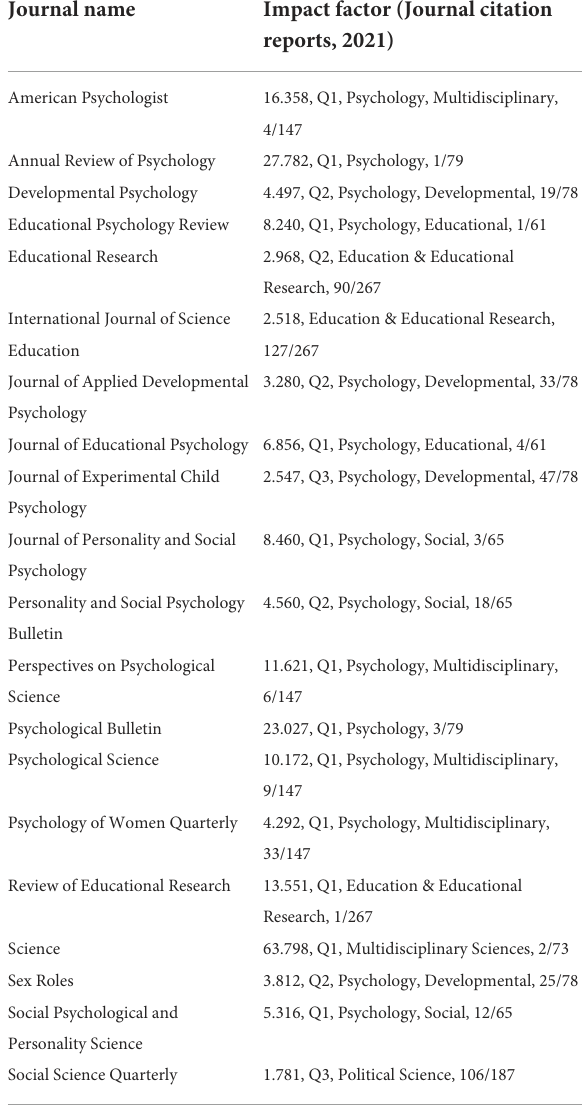
TABLE 2 Influential journals in the social and behavioral